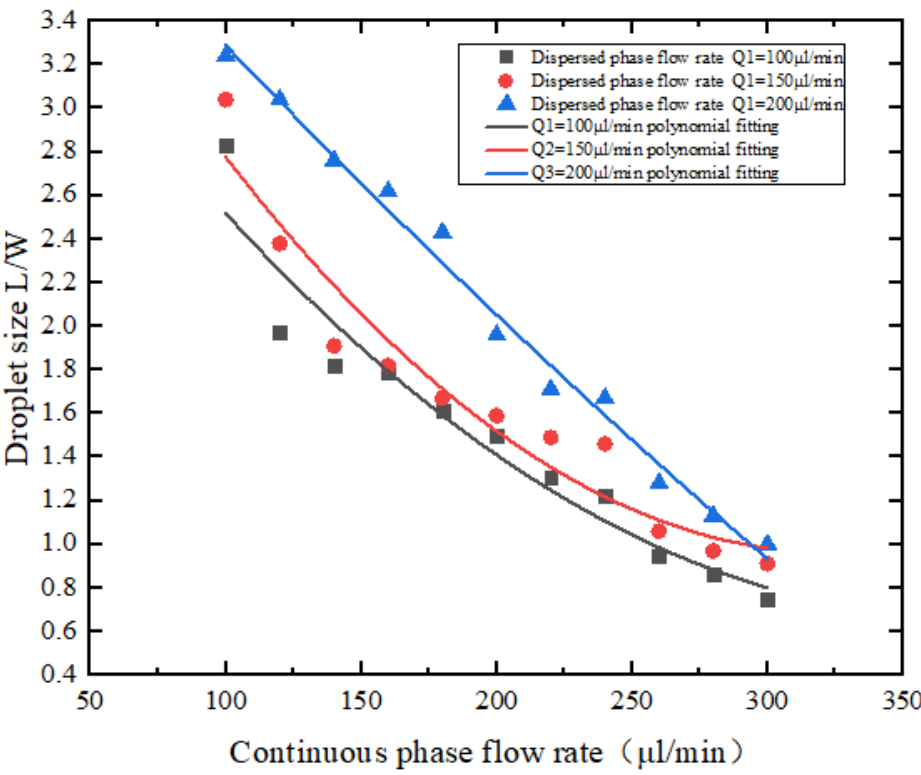
Figure 11. The relationship between continuous phase flow rate and droplet size.